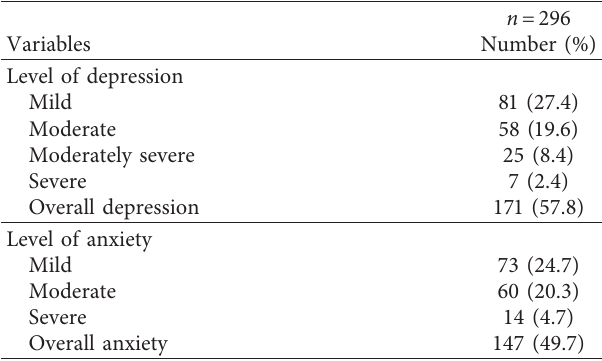
Table 3: Level of depression and anxiety among patients with diabetes